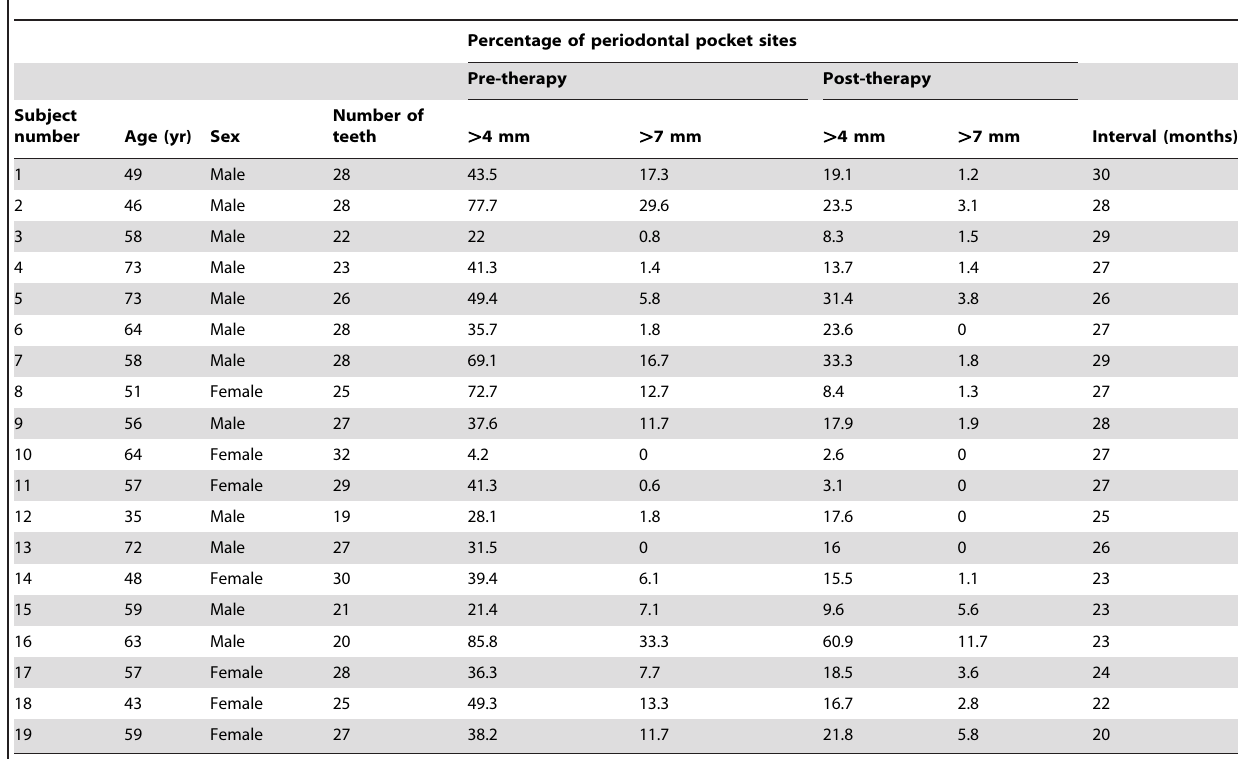
Table 1. Clinical parameters of the 19 subjects enrolled in this